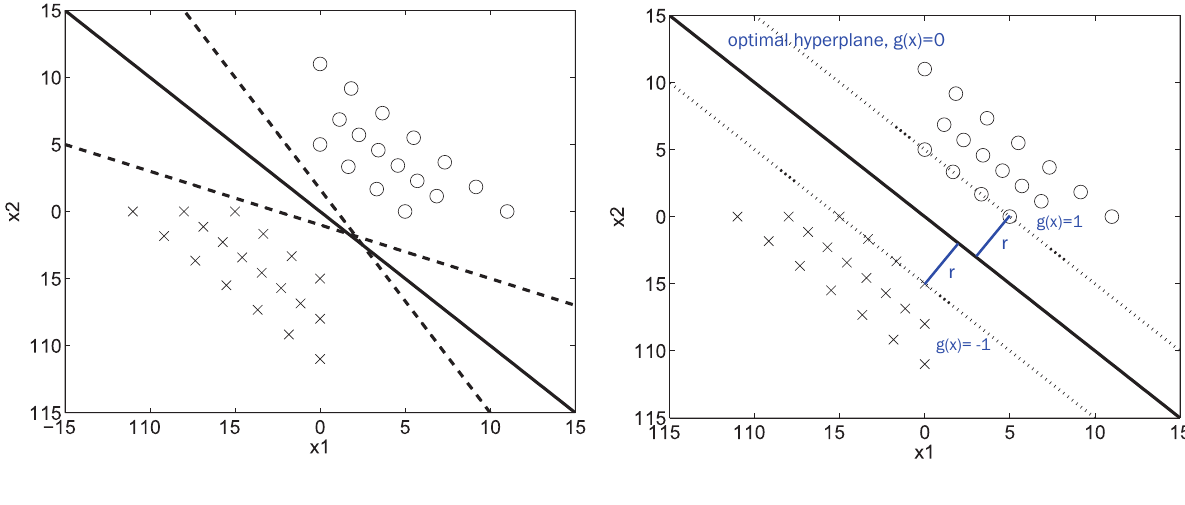
Figure 5. Idea of the SVM in the linear